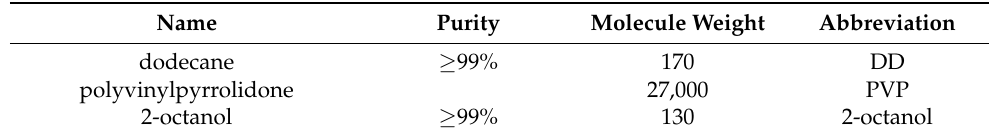
Table 2. List of Table 2. List of reagents. Table 2. List of reagents.